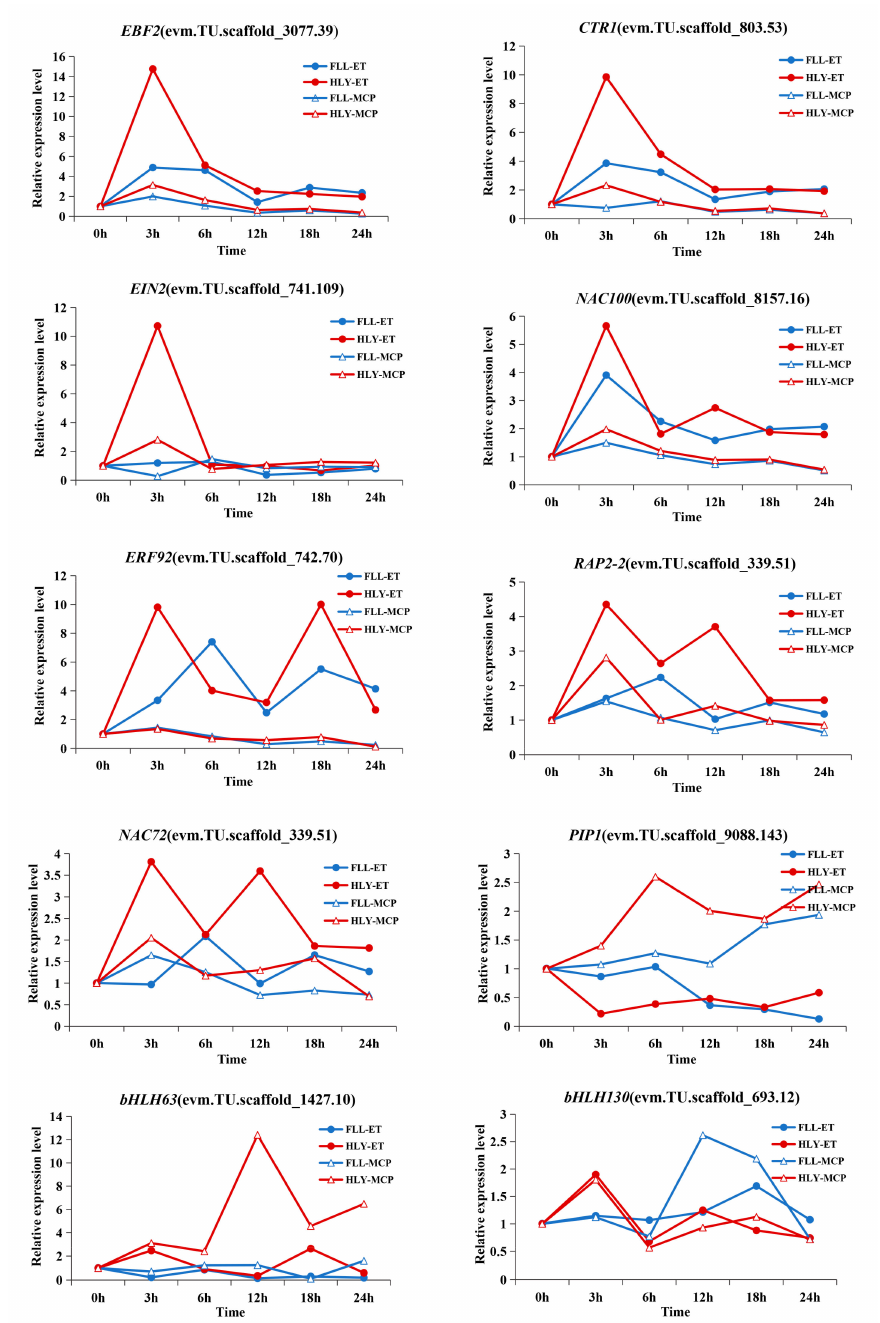
Figure 7. Analysis of DEG expression patterns between ethylene-sensitive and-insensitive varieties. DEG, differentially expressed